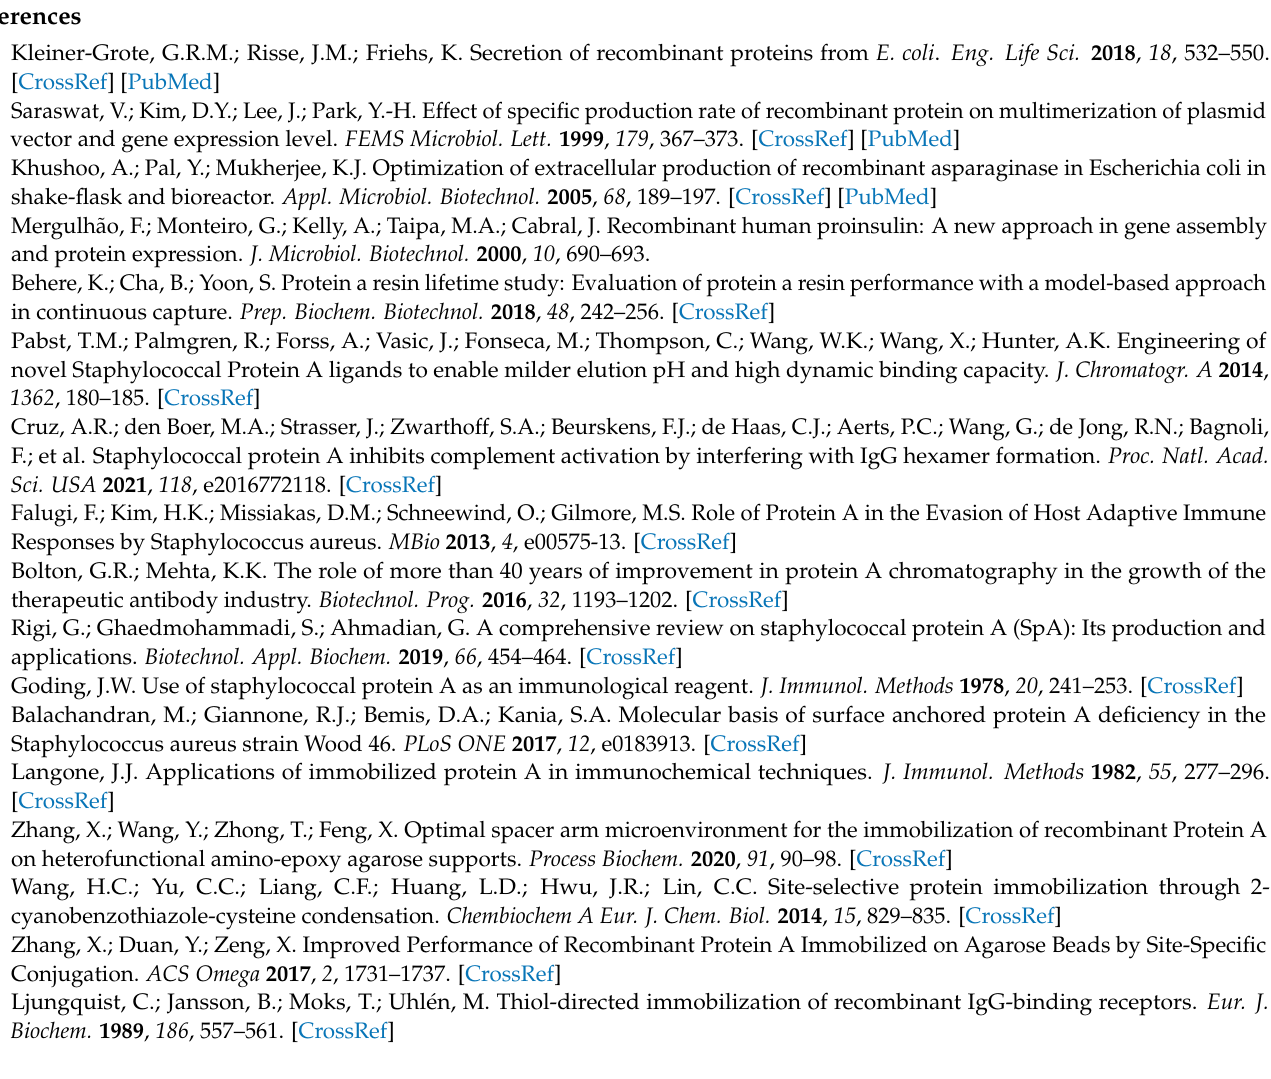
Figure S10: Raw data for IgG bound and Unbound